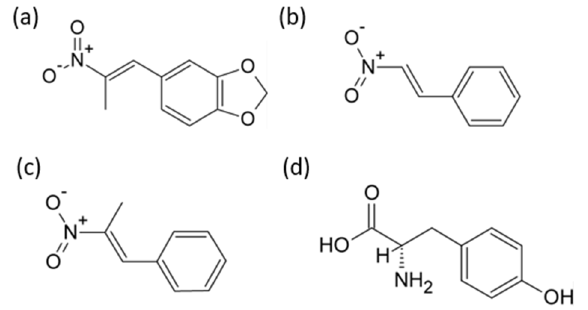
Figure 1. Structural similarity of PTP inhibitors ( a ) NPBD (5-(2-nitroprop-1-enyl)-1,3-benzodioxole), ( b ) NEB, (2-nitroethenylbenzene), and ( c ) NPB (2-nitroprop-1-enylbenzene) to ( d ) Tyrosine, ((2S)-2-amino-3-(4-hydroxyphenyl)propanoic acid).